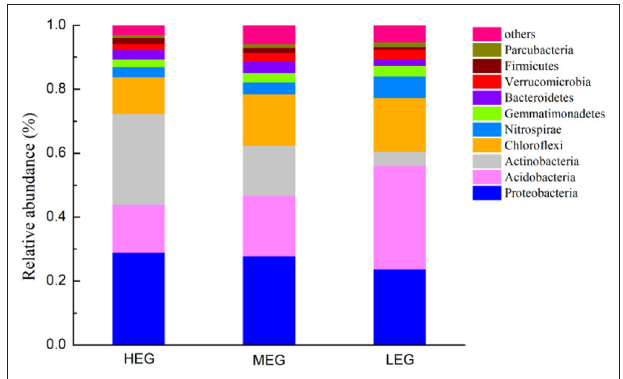
FIGURE 2 | Relative abundance of the dominant bacterial phyla (with average relative abundance > 1%) among three elevational gradients. HEG high elevational gradient, MEG medium elevational gradient, LEG low elevational gradients.